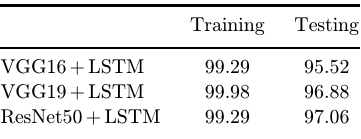
Table 4. Accuracies of VGG16, VGG19 and ResNet50 with